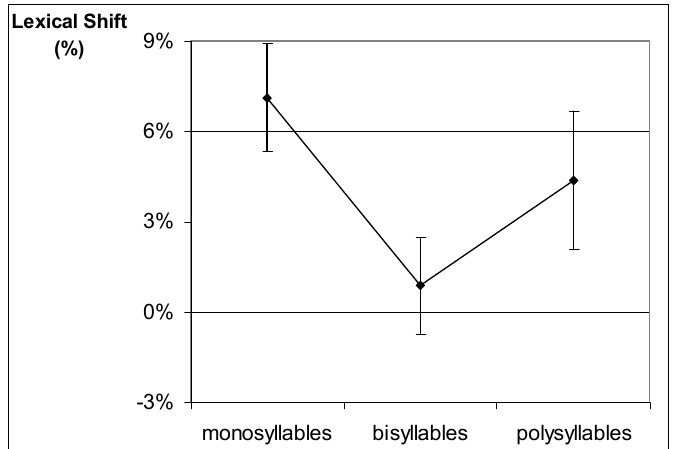
Figure 4: Means and SEs of the lexical shifts for monosyllables (Exp.1), bisyllables (Exp.1) and polysyllables